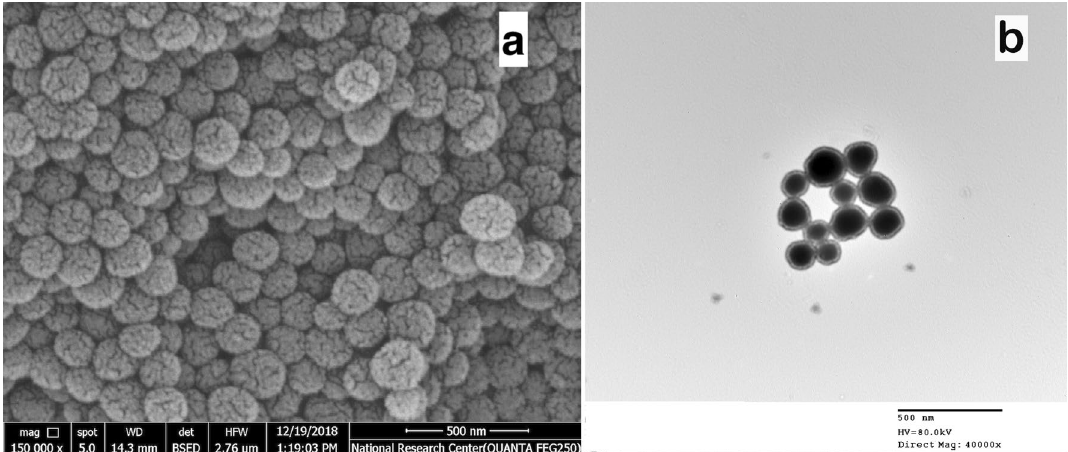
Fig. 5 a SEM micrograph of the extracted sepia melanin (SM) powder, b TEM micrograph of self-assembled tween-based nanoparticles